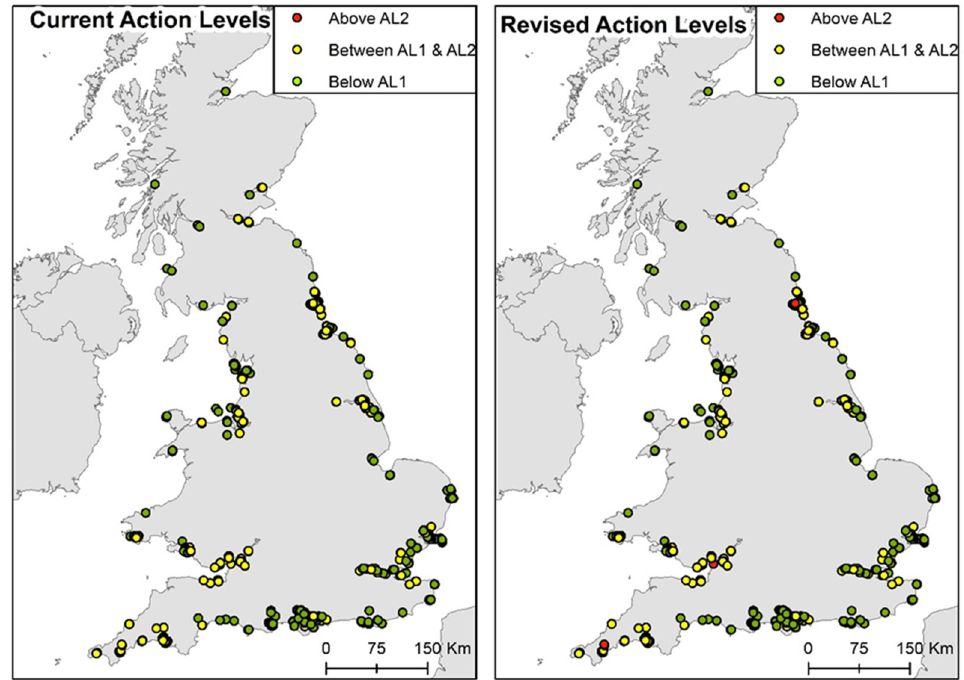
Figure 4. Maps showing the differences between the current ALs and revised ALs for zinc (Zn). Samples above AL2 are indicated in red. Figure adapted from [13].